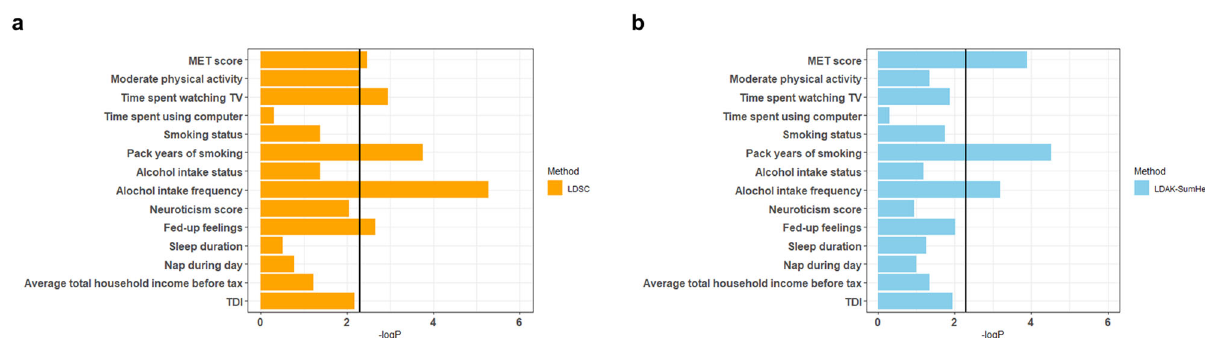
Fig. 2 Bar plots of G × E interaction heritability in BMI. Comparison of results for G × E interaction heritability calculated by LDSC ( a ) and LDAK-SumHer ( b ). The x -axis indicates the – log 10 G × E interaction heritability P -value. MET: metabolic equivalent task; TDI: Townsend depriviation index at recruitment; LDSC: linkage disequilibrium score regression; LDAK-SumHer: linkage disequilibrium adjusted kinships – software for estimating SNP heritability from summary